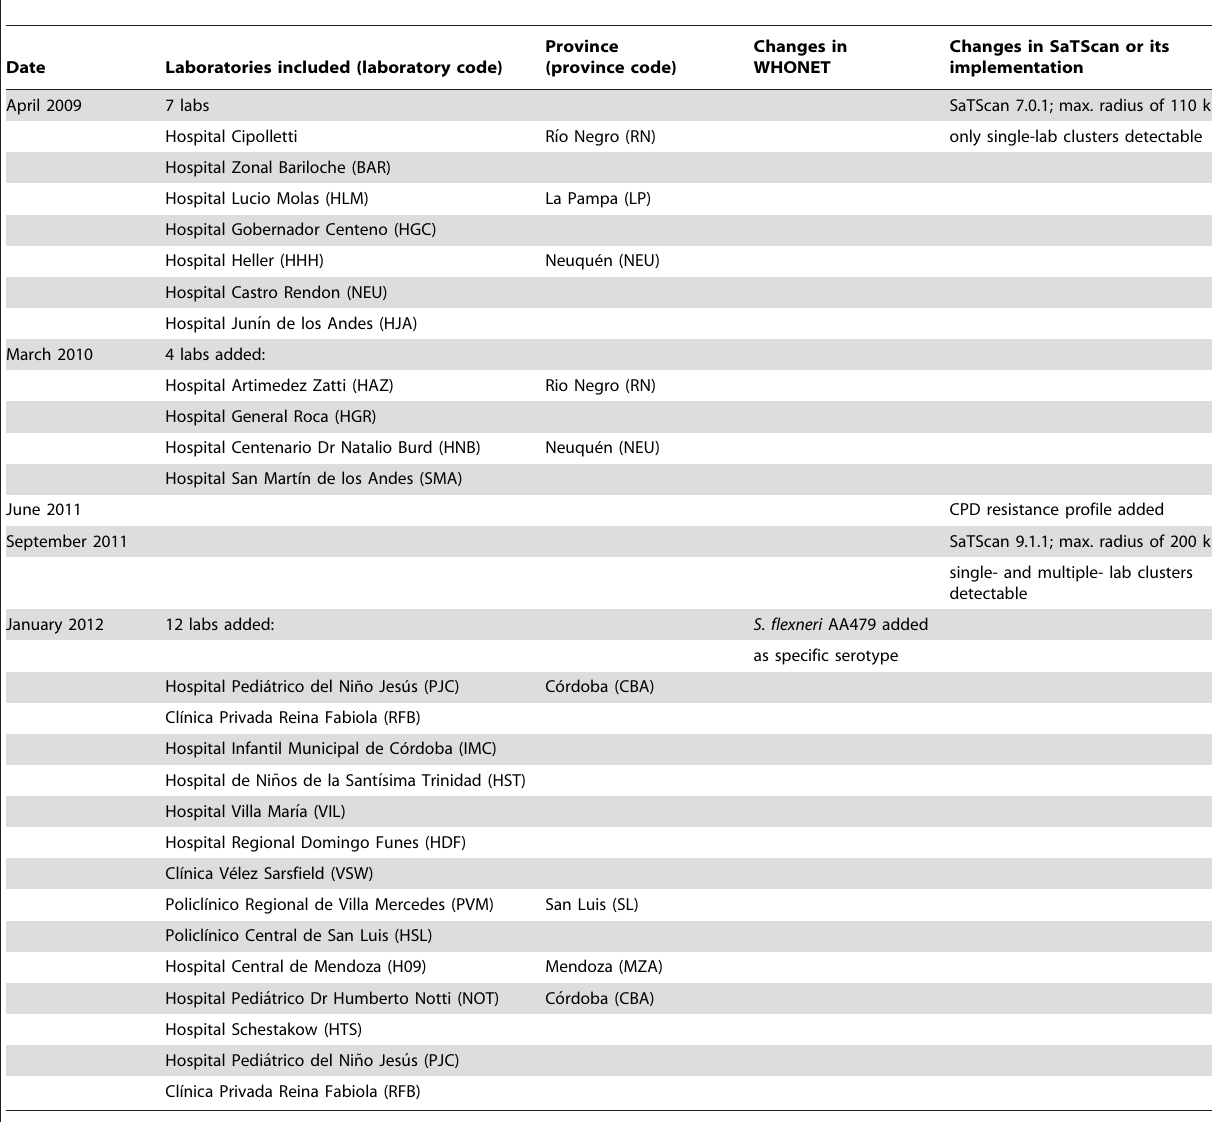
Table 1. Settings of the WHONET-SaTScan surveillance system over the April 2009–March